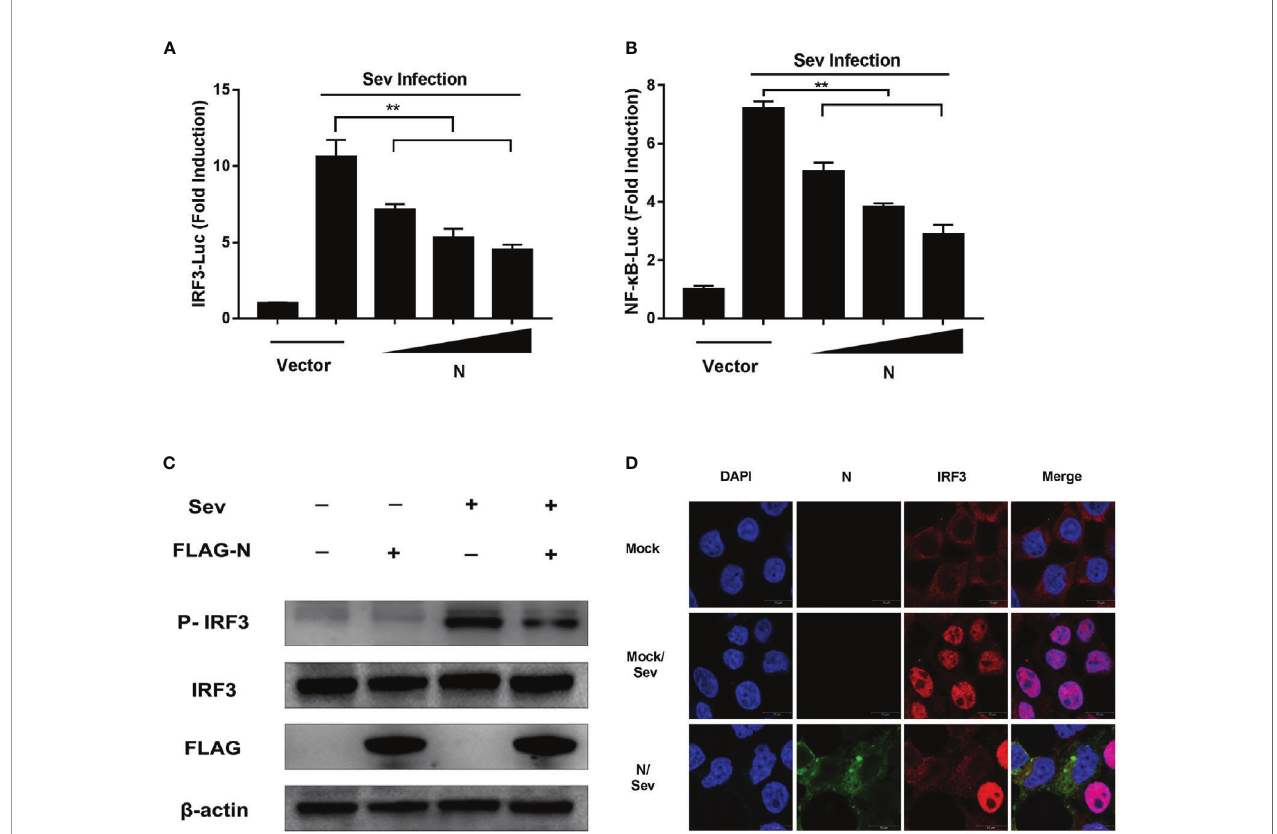
FIGURE 2 | SADS-CoV N protein inhibits Sev-induced phosphorylation and nuclear translocation of IRF-3. HEK-293T cells were co-transfected with pCMV-FLAG-N expression plasmids and the luciferase reporter IRF3-Luc (A) or NF- k B-Luc (B) together with pRL-TK for 24 h and then stimulated with Sev for 12 h. Cell lysates were collected, and the promoter activity of IRF3 or NF- k B was analyzed by Dual-luciferase assay. (C) pCMV-FLAG-N expression plasmids were transfected with HEK-293T cells. After 24 h transfection, cells were treated with Sev for another 12 h. Cell lysates were collected for Western blot analysis with anti-phosphorylated IRF3 (Ser396), anti-IRF3, anti-FLAG, or anti- b -actin antibodies. (D) HEK-293T cells were transfected with pCMV-FLAG-N expression plasmids. After 24 h transfection, cells were treated with Sev for another 8 h. After cell fi xation and permeation, an indirect immuno fl uorescence assay was analyzed with rabbit anti-IRF3 and mouse anti-FLAG antibodies. The confocal laser scanning microscope (Leica SPE; Leica, Germany) was used to detect signals of nuclear translocation of IRF3 (red) and SADS-CoV N protein (green). ** P <